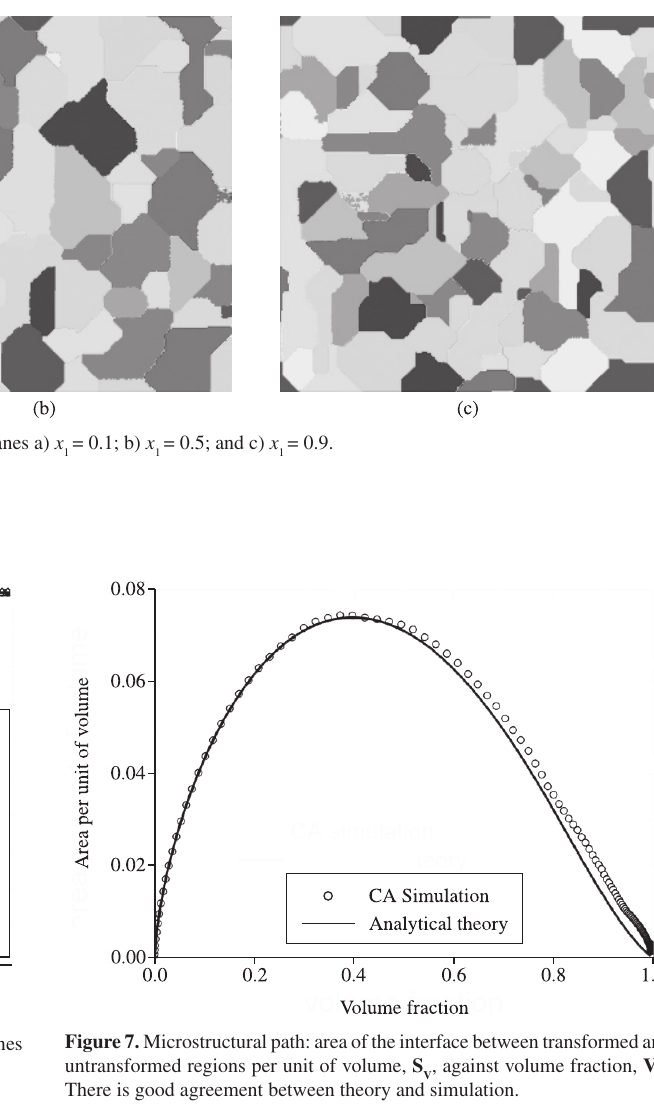
, against volume fraction, V V